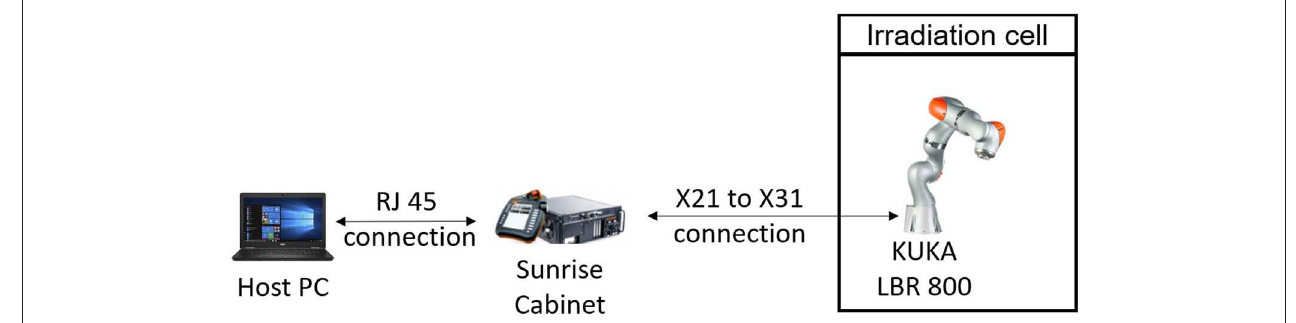
FIGURE 4 | Set-up enabling the control and data recording of the LBR800 robot.